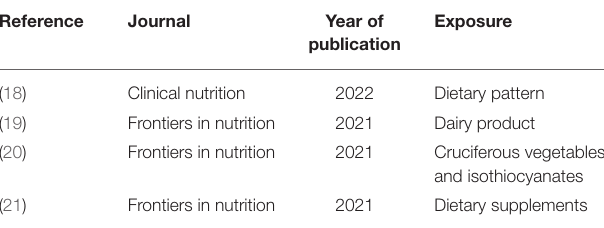
TABLE 4 | Clinical information of OOPS from 2015 to June 2020.